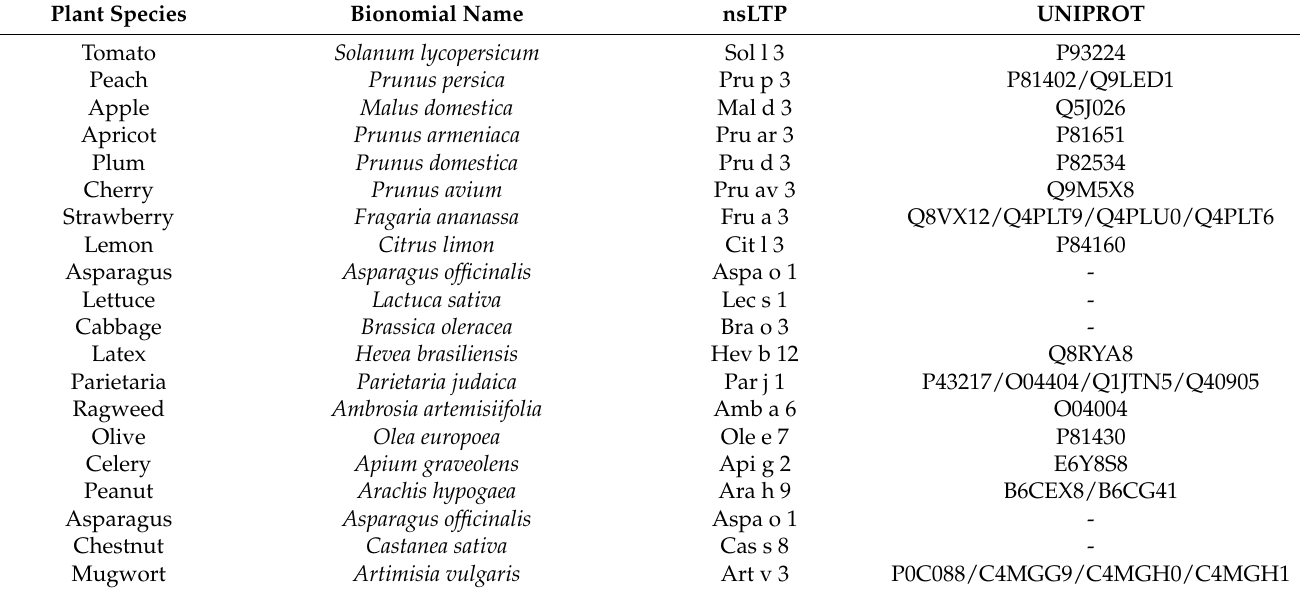
Table 6. Members of the